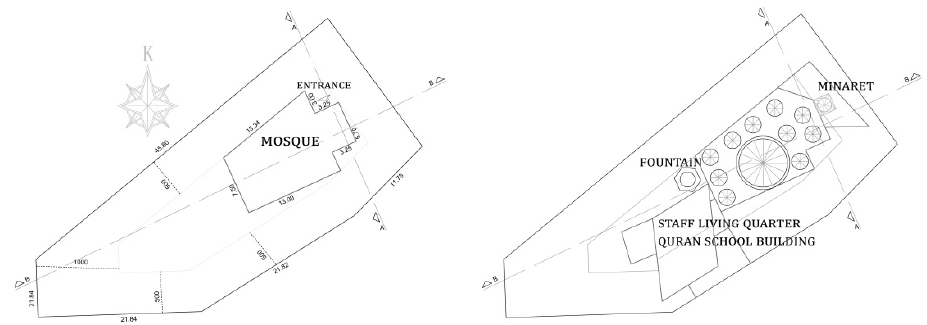
Figure 14. Layout plan for the construction permit of Imam Azam Mosque and its current status.